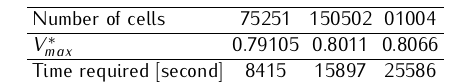
Table 1. Details on mesh